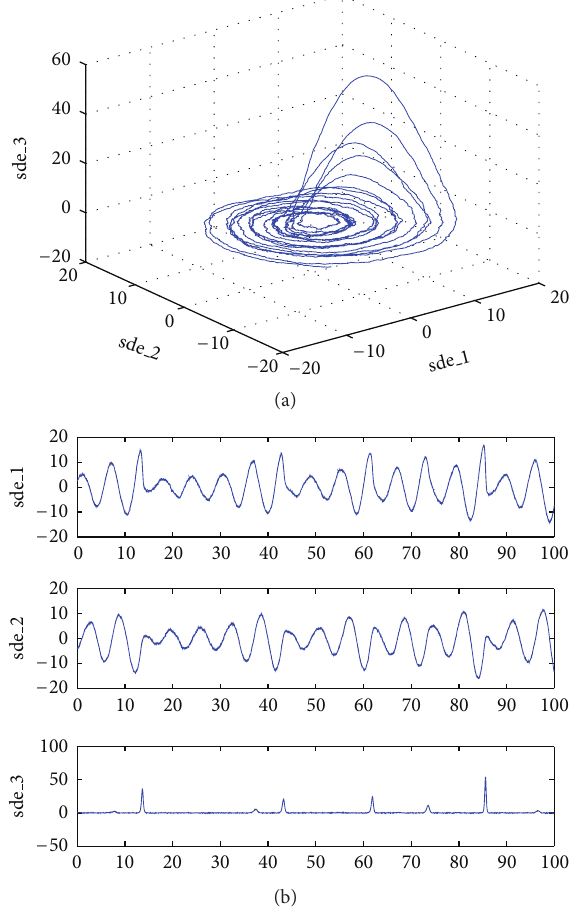
Figure 6: The Lorentz-R¨ossler combining system with the noise = 0.001 , 𝑢 = 0 , 𝑖,𝑗 = 1, 2, 3 𝑢 𝑖𝑖 𝑖𝑗,𝑖 ̸=𝑗